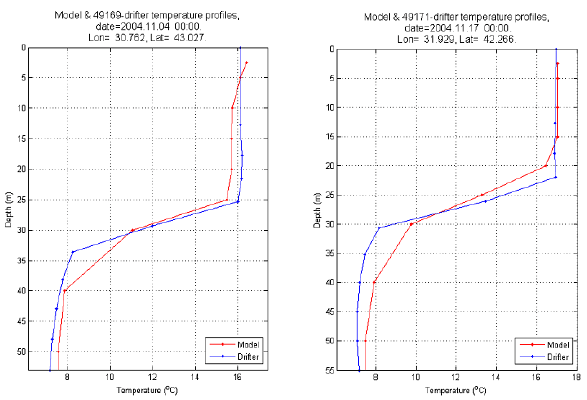
Figure 11. Comparison of the simulated (blue line) and measured (red line) temperature profiles in the upper 70 m during the deepening of the mixed layer. Typically the standard deviation has a maximum on the seasonal thermocline depth. Such maximum has the following explanation. There is a strong temperature gradient in the seasonal thermocline and even small inconsistency of its positioning by the model is resulted in rather significant deviation of temperature.